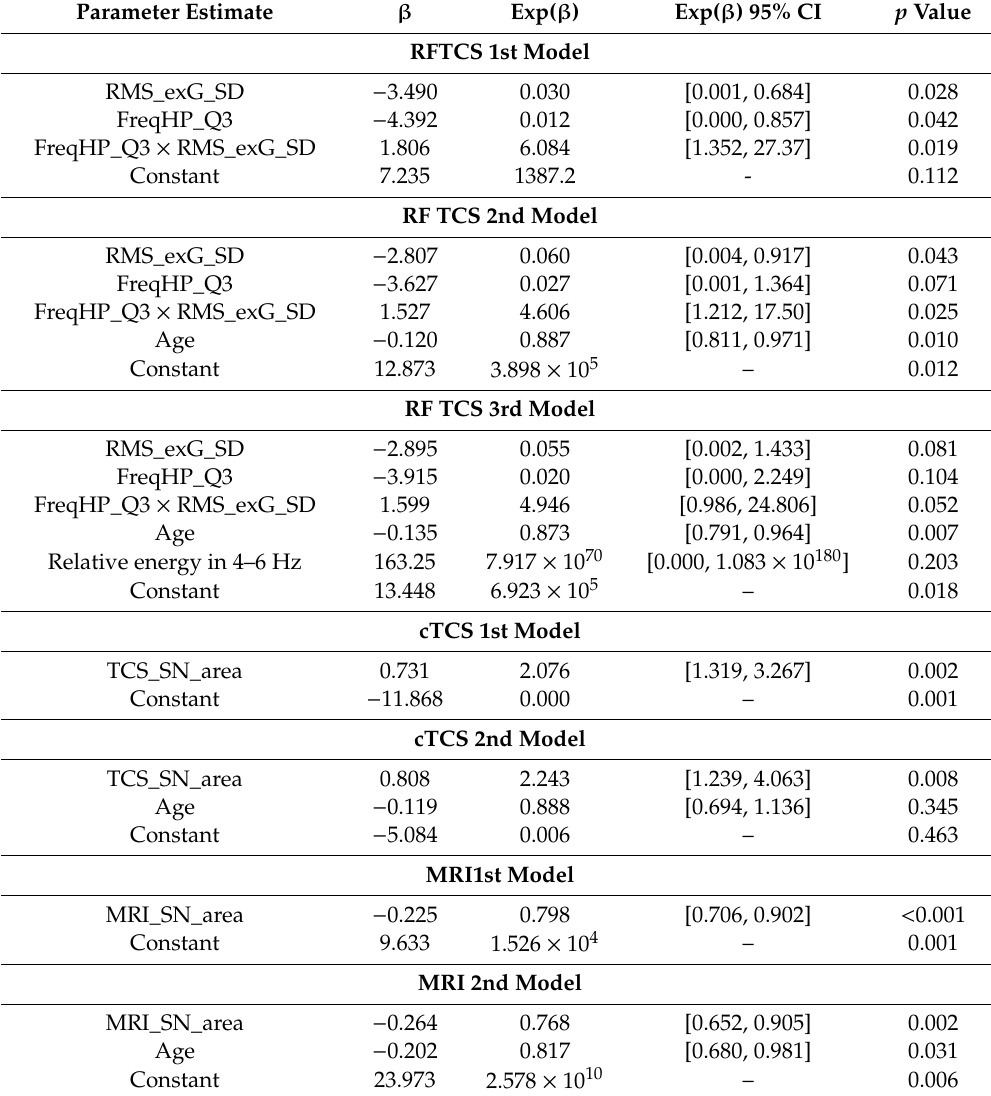
Table 2. The predictive power of the midbrain tissue displacement signal parameters or size of substantia nigra area for the likelihood that the subject has Parkinson’s disease. Results of logistic regression